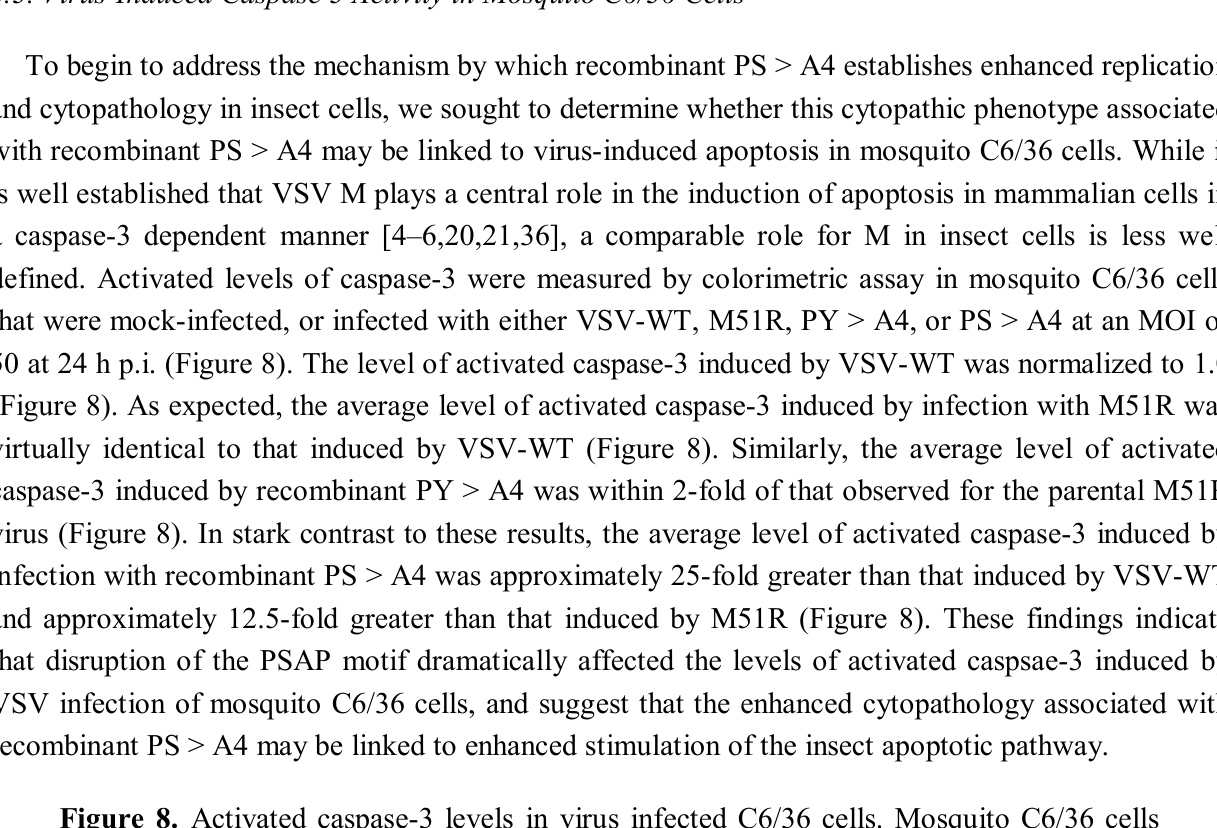
Figure 8. Activated caspase-3 levels in virus infected C6/36 cells. Mosquito C6/36 cells were infected with VSV-WT, M51R, PY > A4, or PS > A4 at an MOI of 50 for 24 h. At 24 h post-infection, cells were harvested and assayed for caspase-3-like activity. Each value represents the average of three independent experiments. The level of